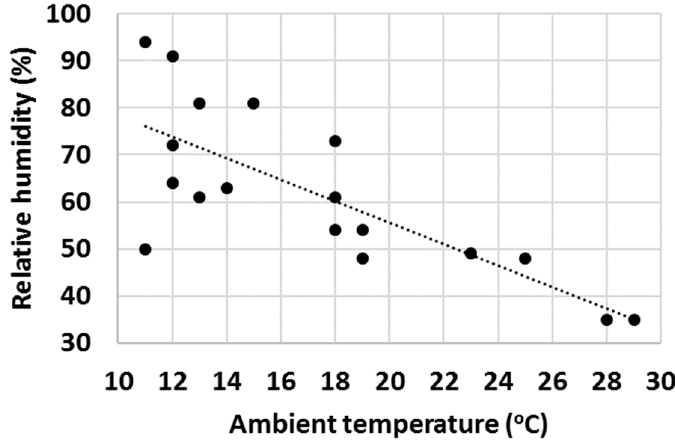
Figure 18. Changes in relative humidity with ambient temperature.